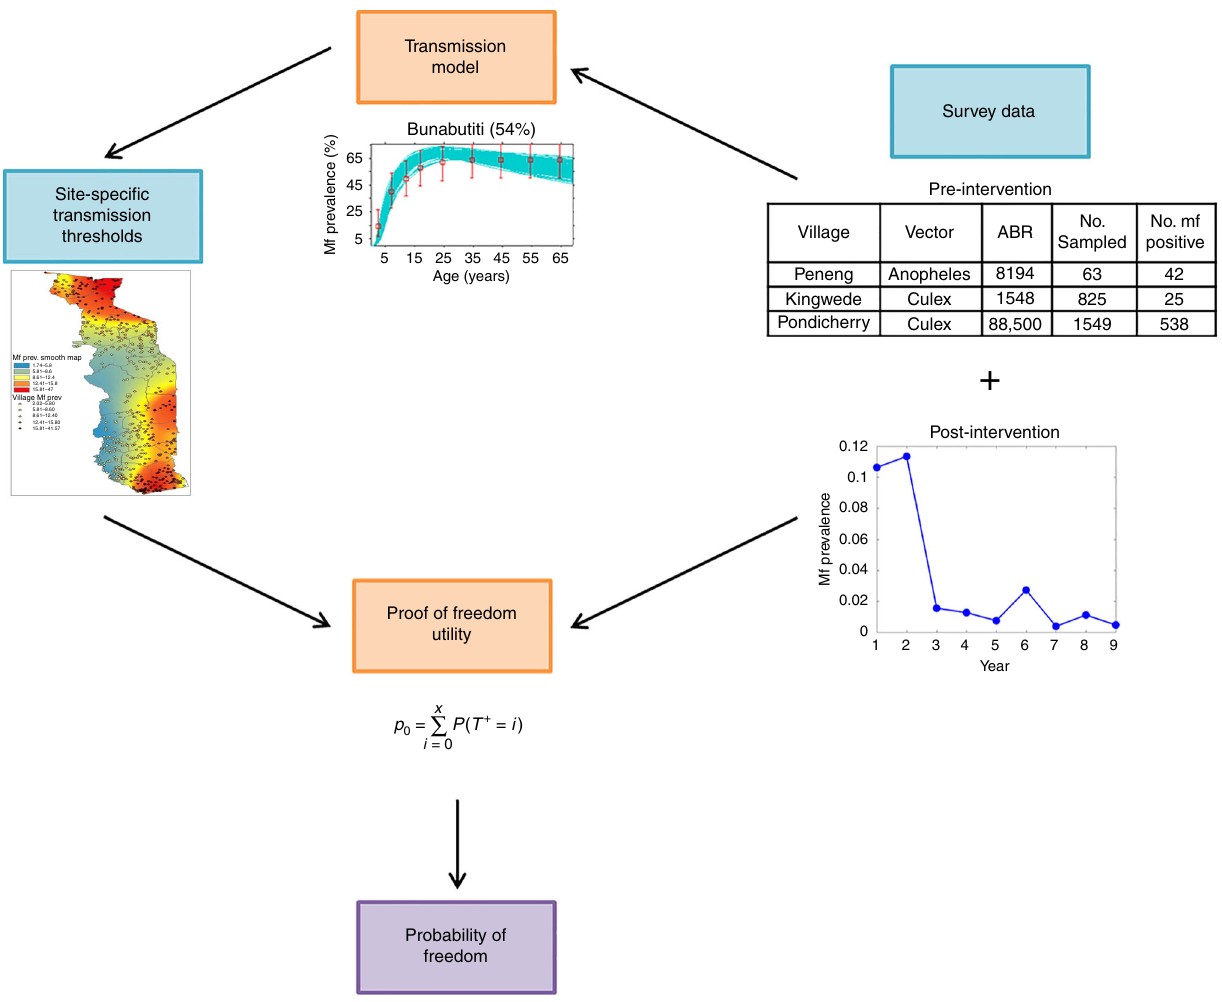
Fig. 2 Integrated parasite freedom from infection tool. The relationship between the two predictive computational tools (orange boxes), site-speci fi c inputs (blue boxes), and the output quantifying the probability of freedom (purple box) is displayed graphically. The pre-intervention survey data inform the calibration of the transmission model, whereas the estimated site-speci fi c Mf prevalence thresholds and post-intervention survey data informs the freedom from infection calculations. The images included in this fi gure are illustrative in nature and the data shown are not pertinent to this study. A complete set of pre-intervention survey data used for calibration the model includes the site location, the vector species responsible for transmission, the prevailing annual biting rate, and the baseline mf survey results (data from 6 ). The map of site-speci fi c transmission thresholds highlights the spatial heterogeneity of breakpoints used here for de fi ning the design prevalence in the PFFI calculations (data from 69,70 )